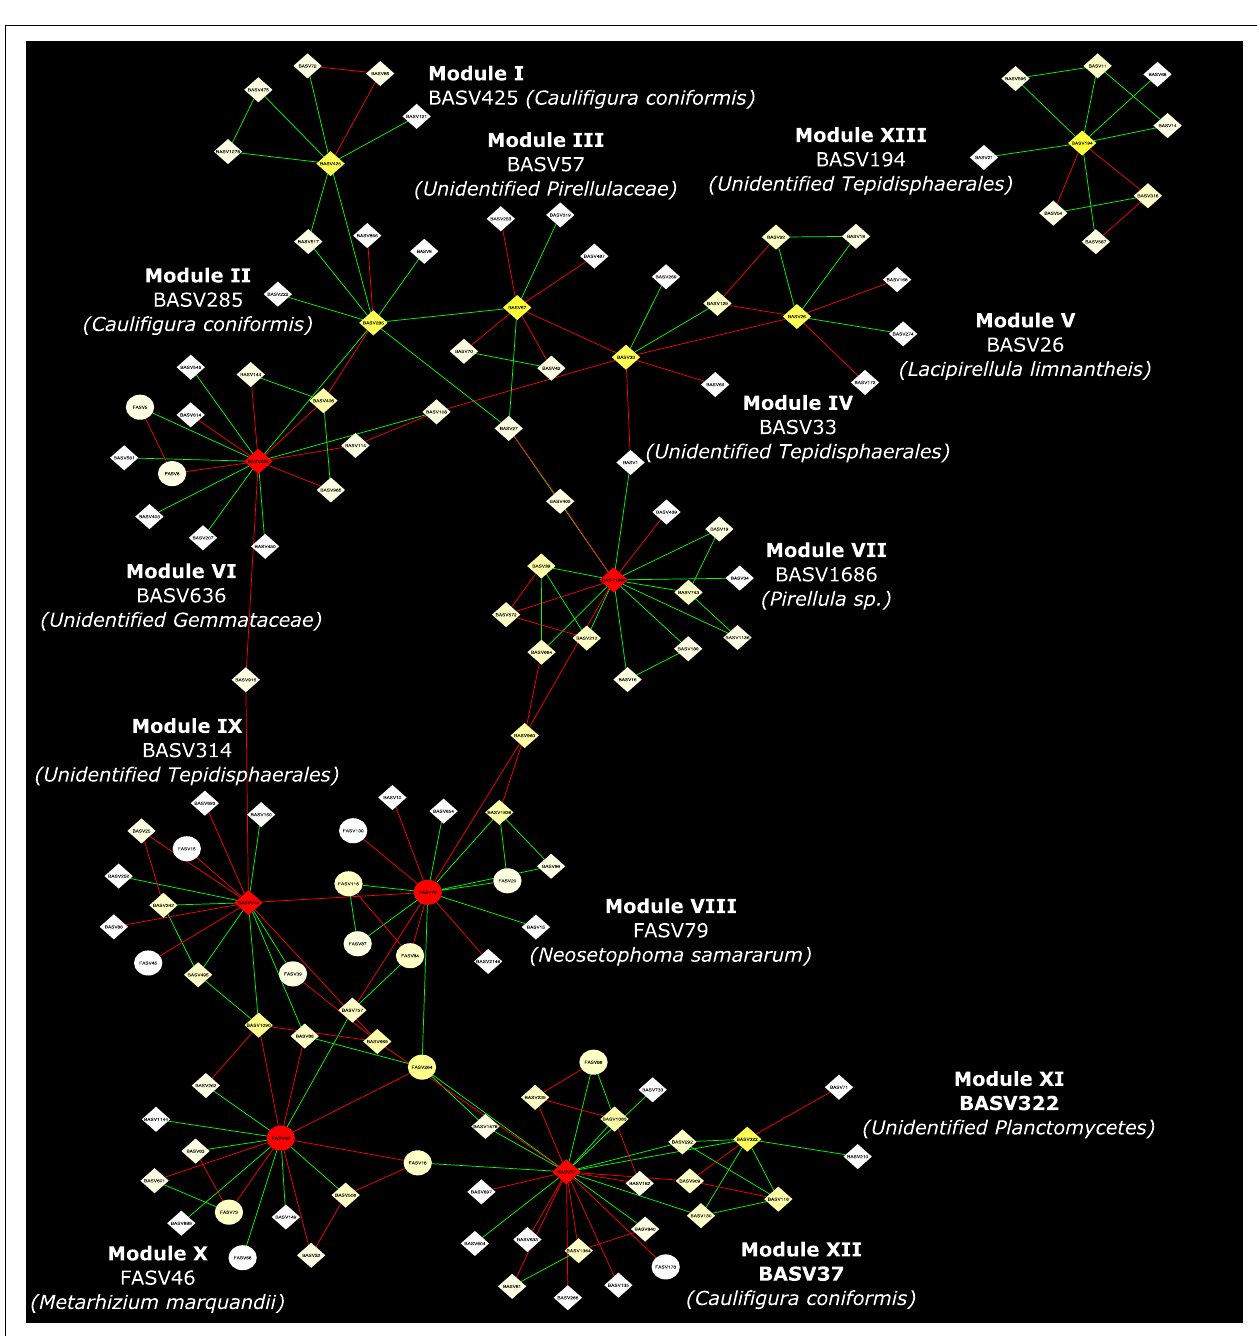
FIGURE 8 | Network hub taxa identified across six hemp fields in New York. Interkingdom interactions of hub taxa in the root and rhizosphere soil was analyzed using three replicates. The co-association of each hub taxa and its co-associated ASVs is denoted as a Module and ASV connecting between Modules considered as connector taxa. Hub taxa of the module and connector taxa combinedly considered as Network hub taxa. Here soil refers to rhizosphere